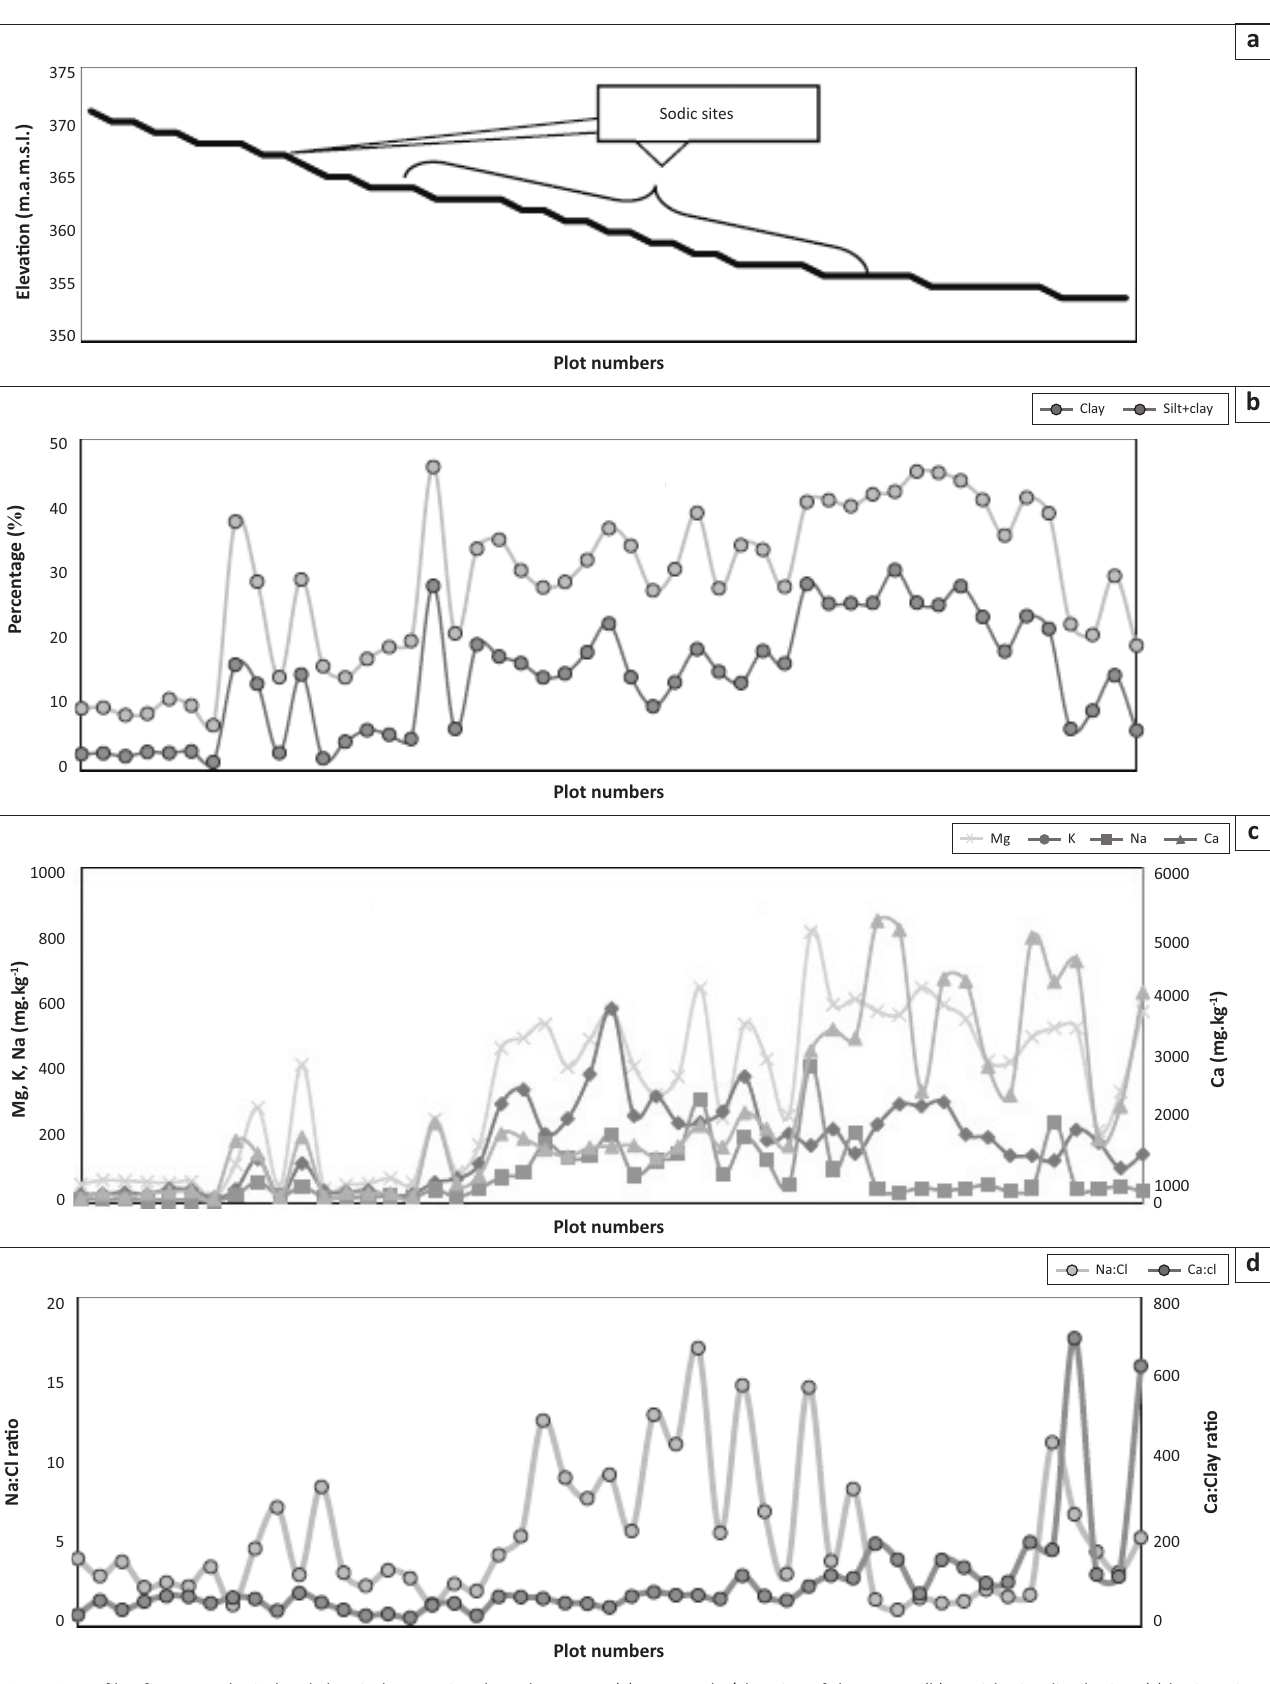
FIGURE 3: Profile of average physical and chemical properties along the catena. (a) Topography/elevation of the catena, (b) particle size distribution, (c) basic cations, (d) selected cation to clay ratios and (e) pH and exchangeable sodium